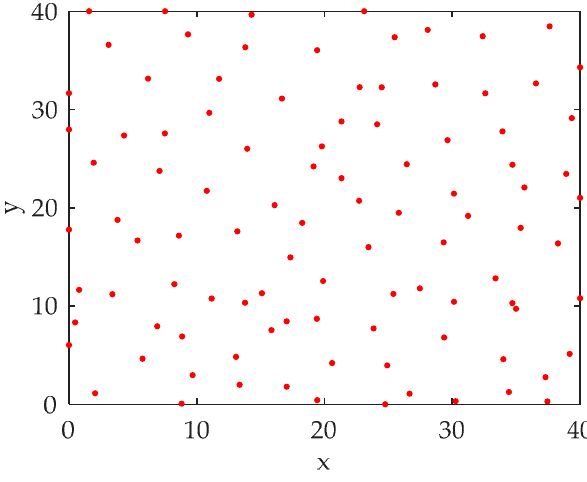
Figure 7. Sensor deployment plan.